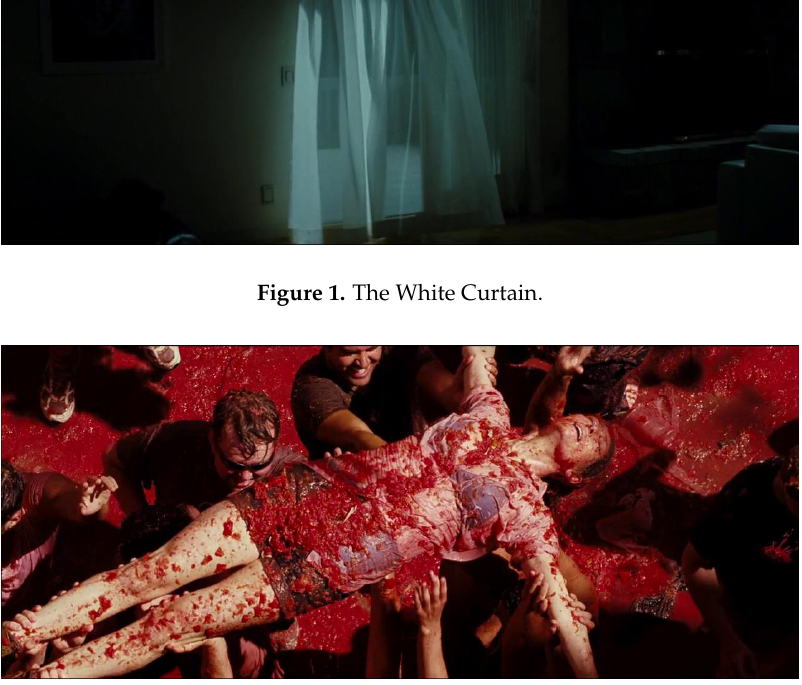
Figure 2. Eva at the La Tomatina festivities.